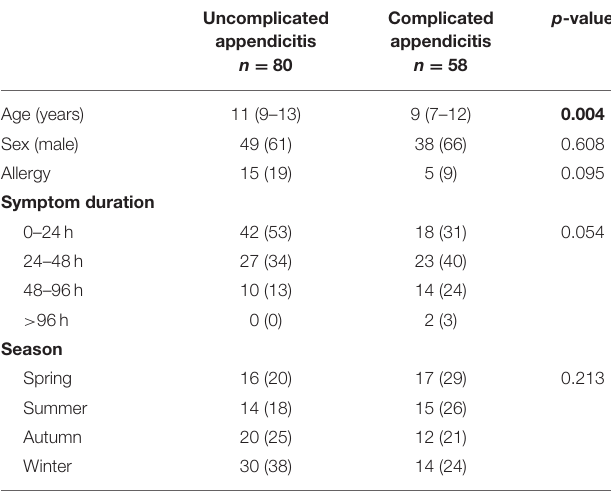
TABLE 2 | Levels of interleukins and IgE in 138 children with uncomplicated and complicated appendicitis. Uncomplicated appendicitis